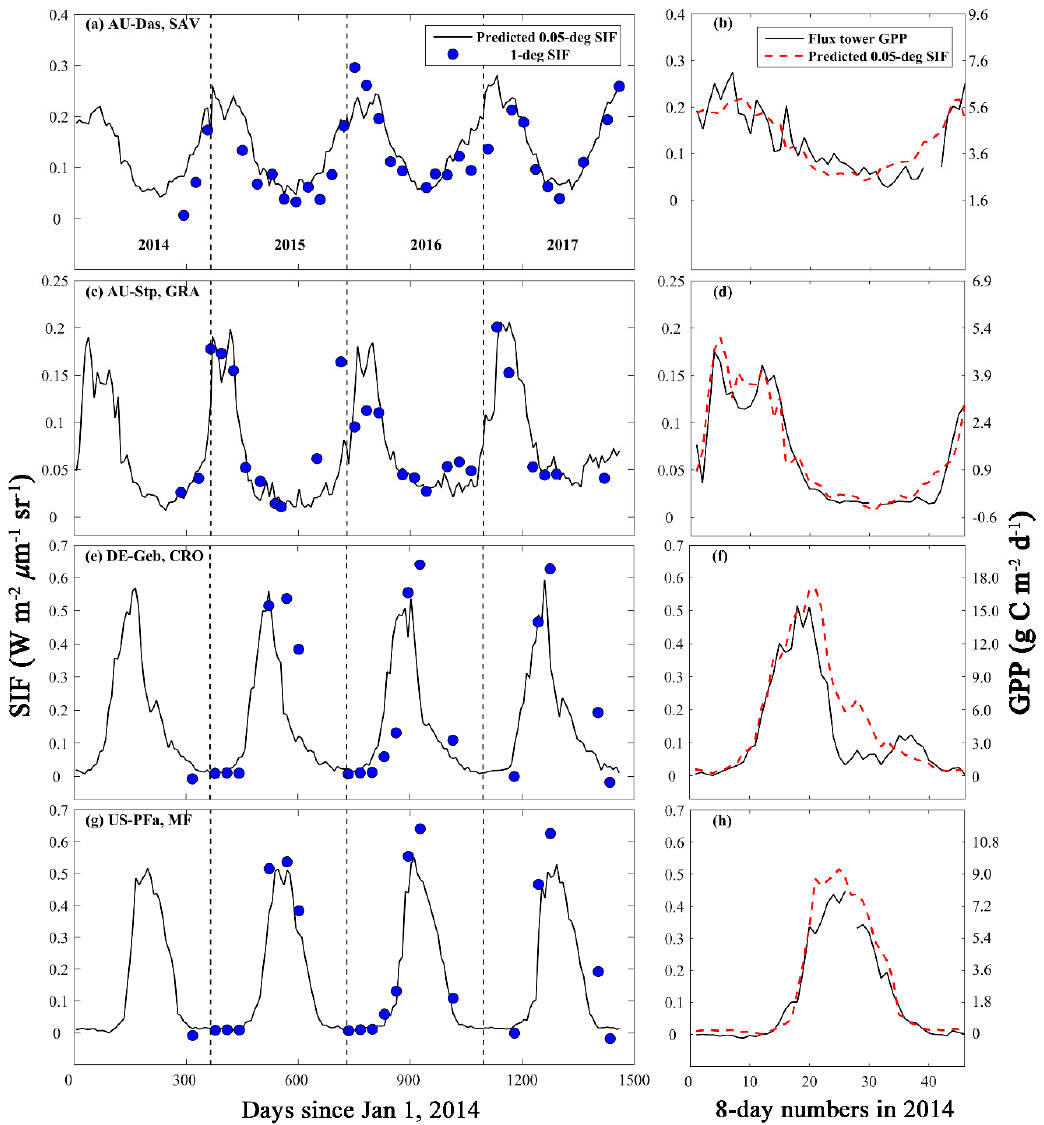
Figure 7. The seasonal cycles of our new 0.05 ◦ SIF, 1 ◦ OCO-2 SIF directly aggregated from discrete SIF soundings, and tower-based gross primary productivity (GPP) at four eddy covariance (EC) flux tower sites: ( a , b ) AU-Das, savannas (SAV), ( c , d ) AU-Stp, grasslands (GRA), ( e , f ) DE-Geb, croplands (CRO), and ( g , h ) US-PFa, mixed forests (MF). The tower-based GPP was temporally aggregated to 8-day intervals to be consistent with the temporal resolution of the new 0.05 ◦ SIF.